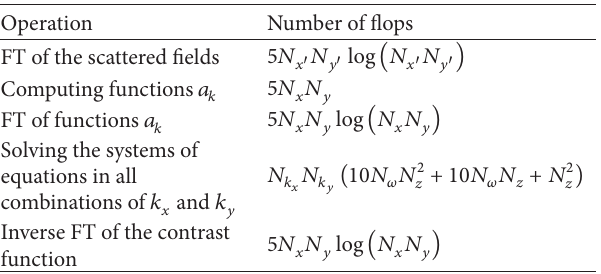
Table 1: Details of computational complexity of the proposed image reconstruction